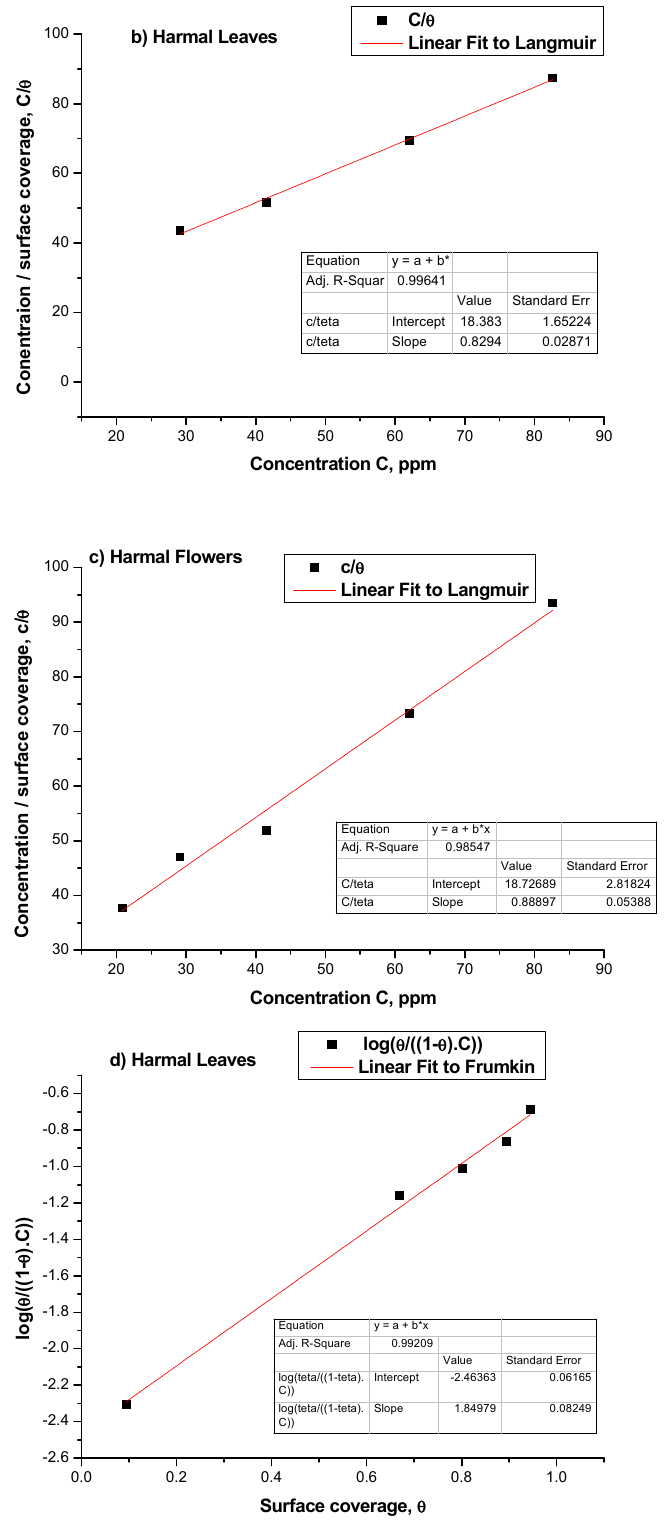
Figure 10. Langmuir adsorption isotherm of Harmal ( a ) roots, ( b ) leaves, and ( c ) flower extract, and ( d ) Frumkin adsorption isotherm of Harmal leaves extract; for all concentrations on carbon steel electrode in 0.25M H 2 SO 4 at 298 K. The Langmuir isotherm model monitors the variation of adsorption coefficient K ads with a concentration of inhibitor C according to the following relationship Equation (5)